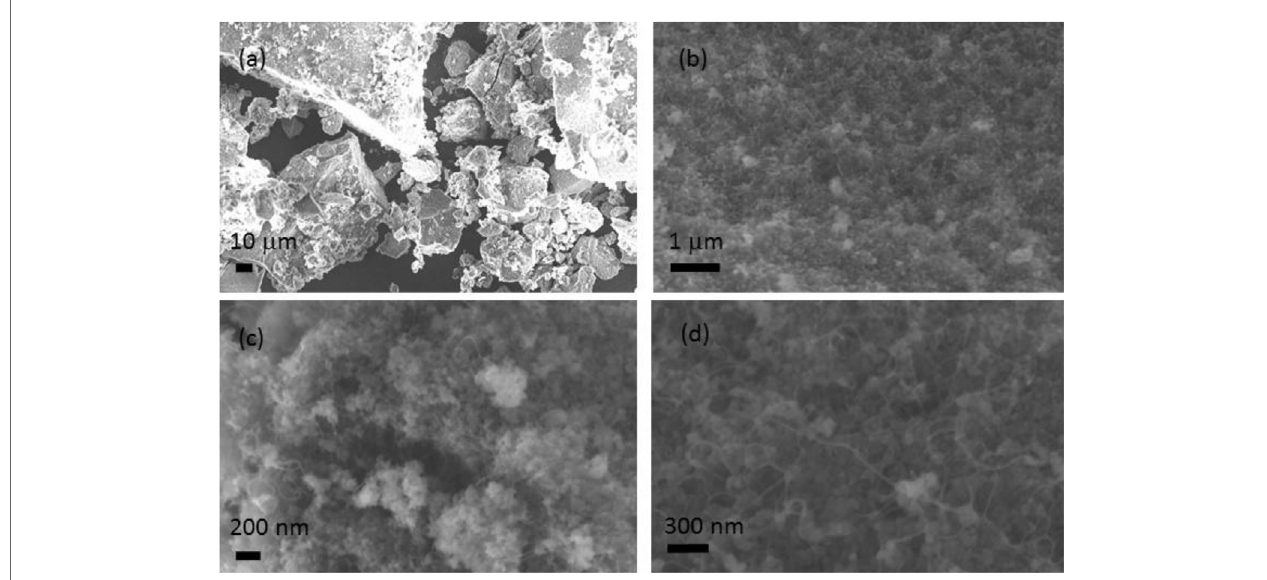
FigUre 1 | seM images of the as-made sWcnTs on siO x support at different microscopic resolutions . Both the nanotubes and SiOx particles can be seen from the images. From (a – D) the images of the same sample with gradually increased resolutions.